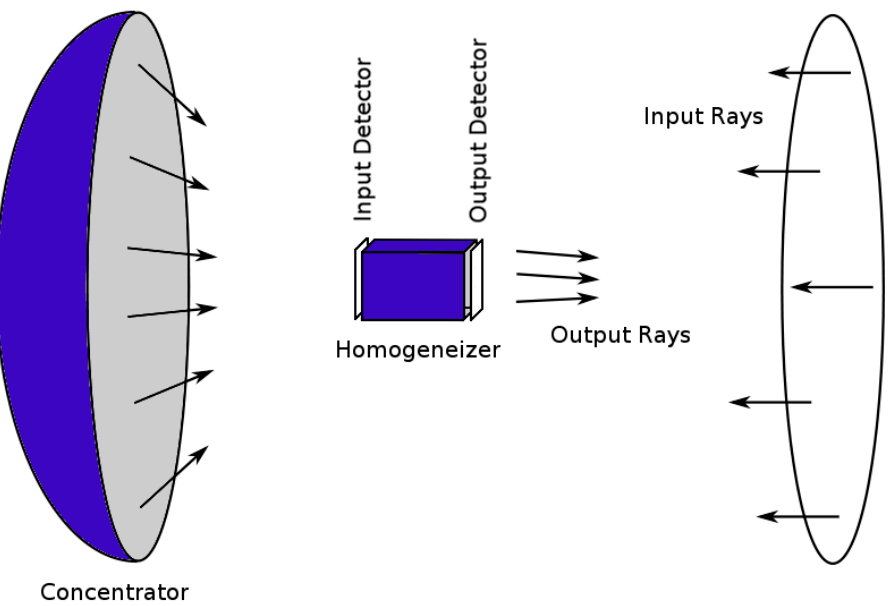
Figure 2. General modelling layout used in this work: Random parallel rays generated in a circle equivalent to the projected concentrator, are reflected by the concentrator to the focal zone, where they are successively reflected inside the homogenizer. The whole experiment is monitored by detectors positioned immediately before and after the homogenizer.